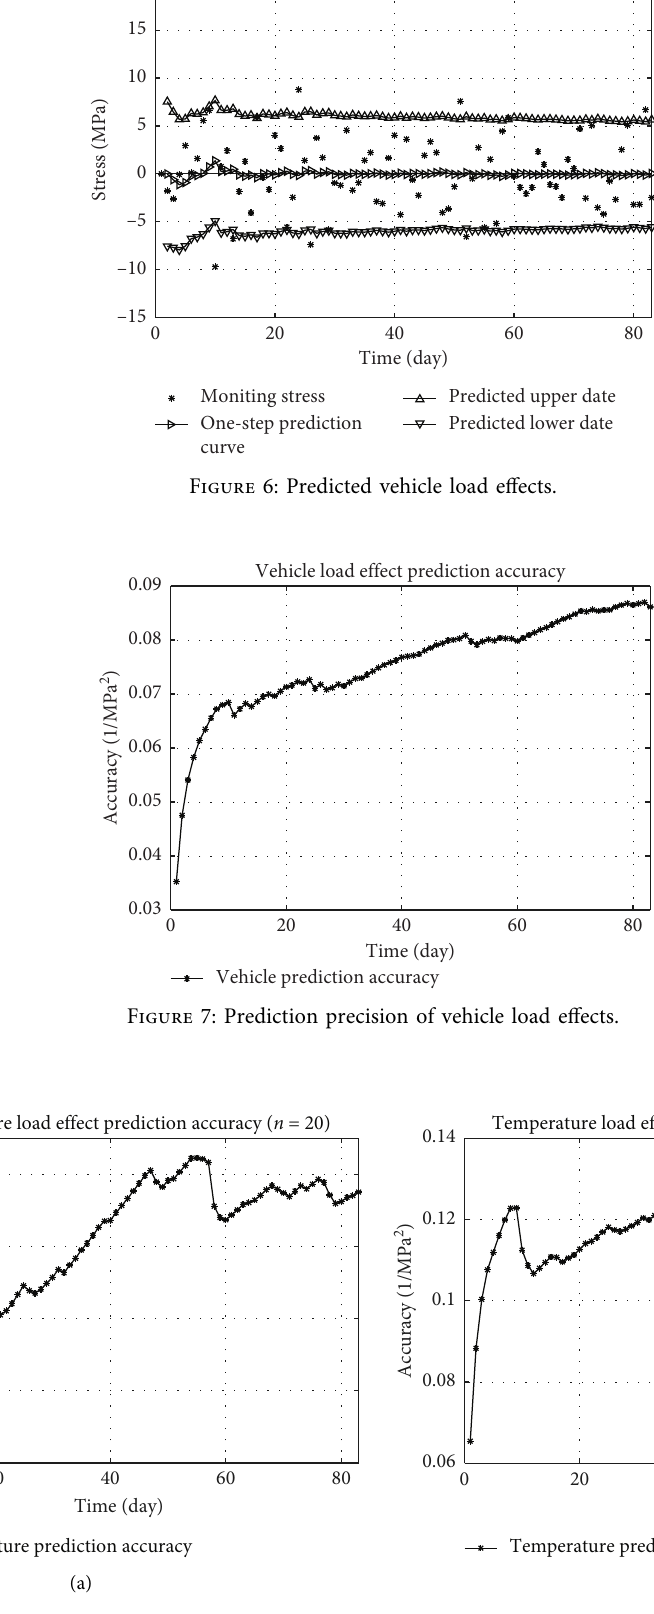
� 20. (b) n � . (a) n 1 , 0 1 , 0 1 , 0